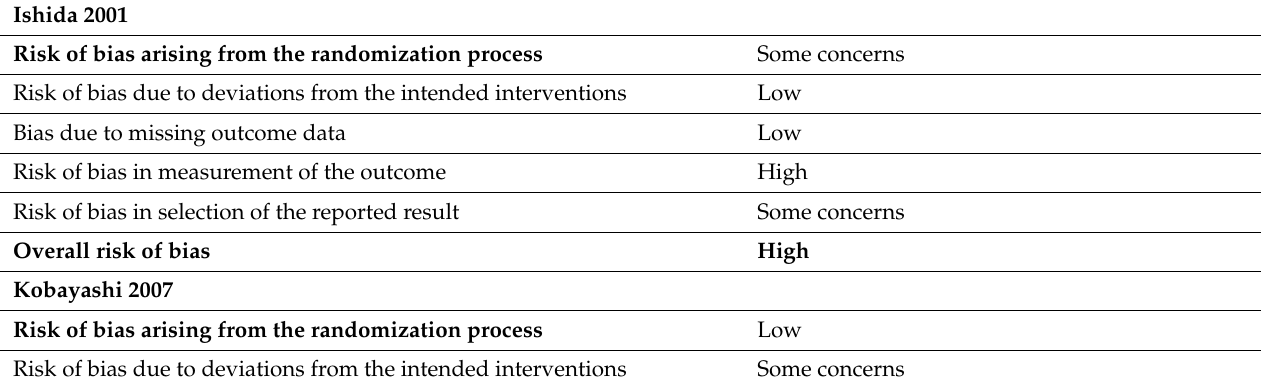
Table A1. Risk of bias assessment of included